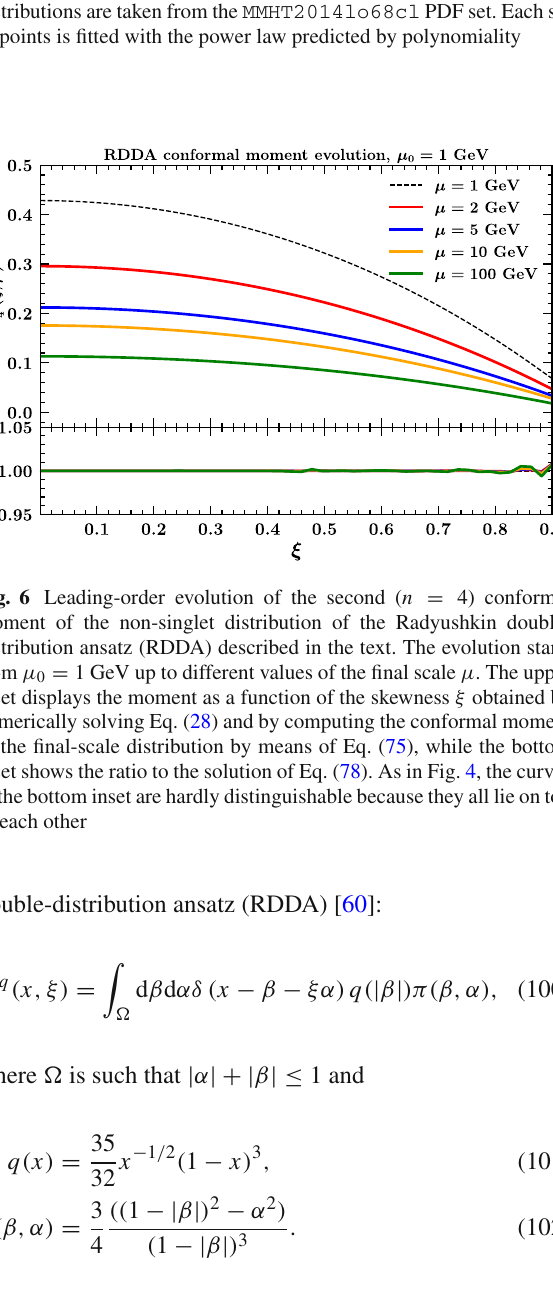
distributions are taken from the MMHT2014lo68cl PDF set. Each set of points is fitted with the power law predicted by polynomiality